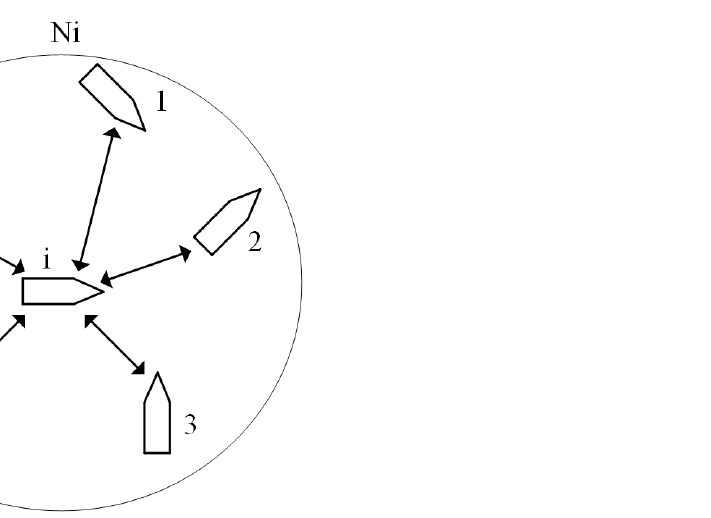
Figure 2. The i th USV and its circle neighborhood (N i represents the set of neighbors of i th USV, i = 1, 2, ...,